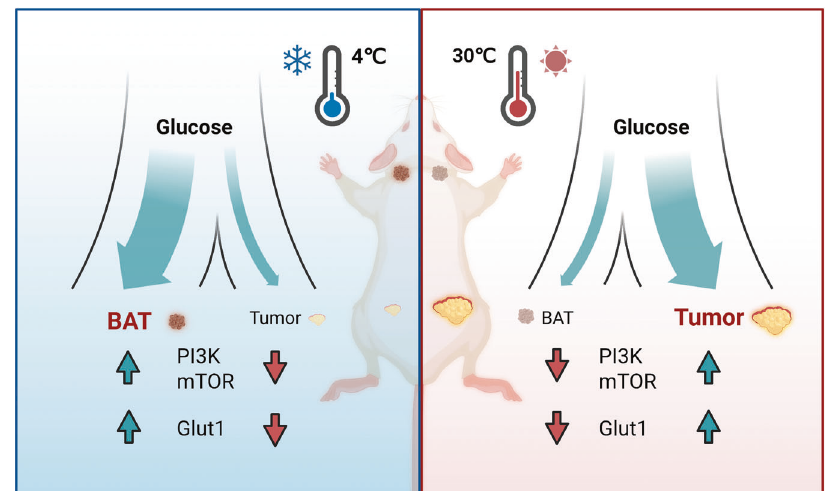
Fig. 1 Cold-induced brown adipose tissue thermogenesis leads to tumor suppression by competing for supply of circulating glucose. In tumor-bearing mice under thermoneutral ambient temperature, more glucose is distributed to the tumor to support glycolysis and stimulate multiple metabolic pathways to facilitate tumor growth. Seki et.al report that brown adipose tissue activation during cold acclimatization favors glucose distribution to BAT and limits the tumor growth. Illustration is created with